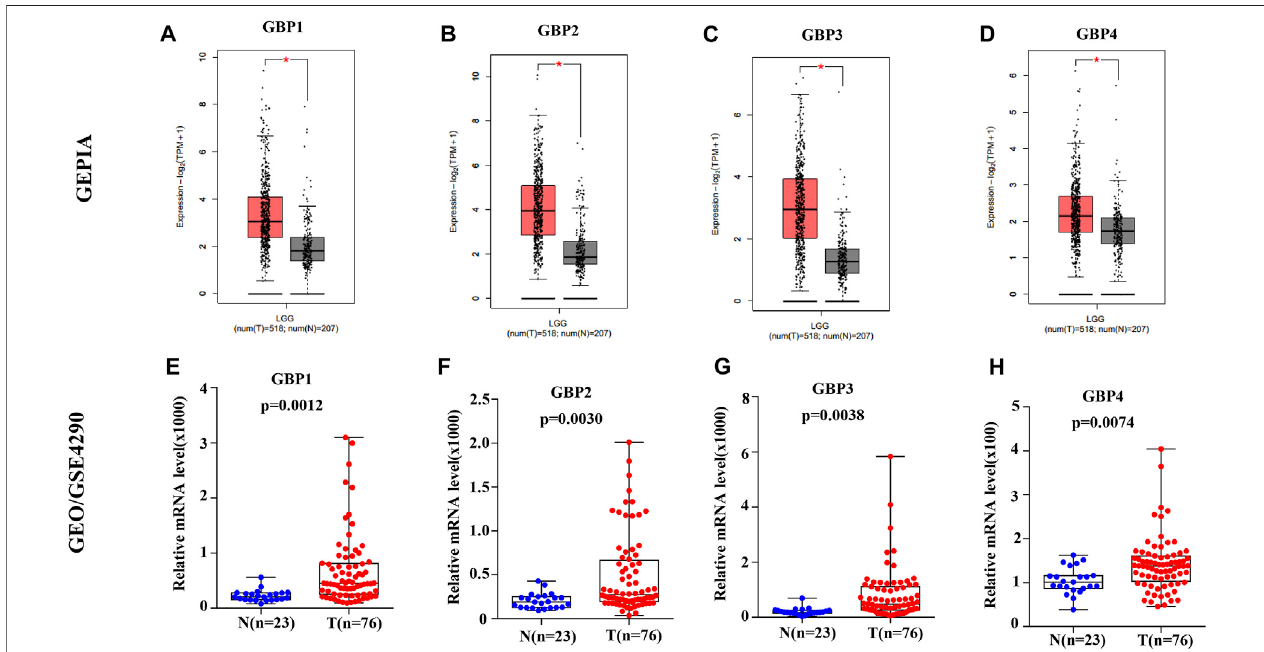
FIGURE2| The expression levels ofGBP1, 2,3,4inlower-gradeglioma (LGG) patients.The expression levelsof (A) GBP1 (B) GBP2, (C) GBP3,and (D) GBP4in LGG tissues vs normal tissues (GEPIA). The expression levels of (E) GBP1 (F) GBP2, (G) GBP3, and (H) GBP4 in LGG tissues vs normal tissues (GSE4290). * p < 0.05.